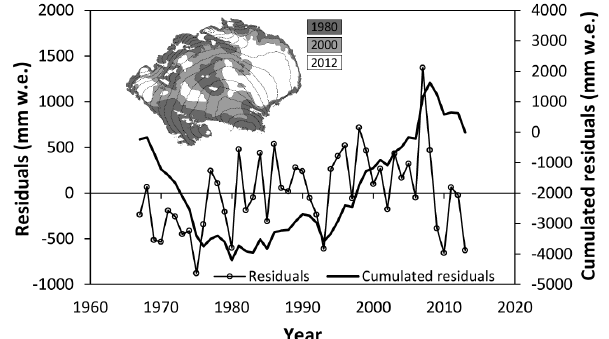
Figure 10. Plot of residuals of the multiple linear regression of B a versus Oct–May precipitation and Jun–Sep temperature on the Careser Glacier. Multiple regression coefficients are reported in Ta- ble 6. The inset shows the extent of the glacier in three different